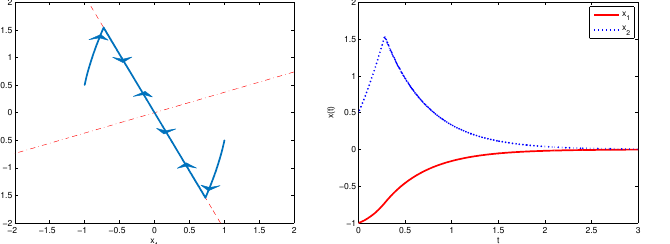
Figure 2. The stable dynamics ( Left ) and convergent response curves ( Right ) of the system in Example 2.